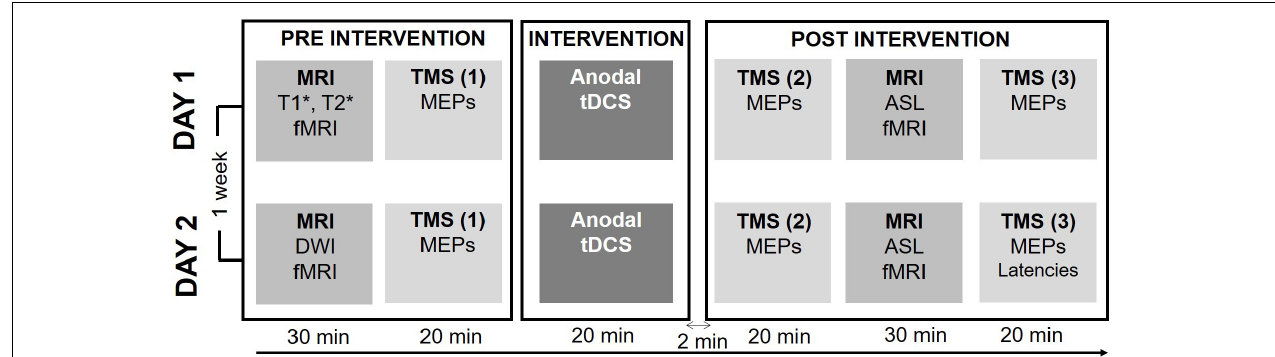
FIGURE 1 | Experimental procedure. Each session started by a baseline measure consisting of a structural and functional MRI (fMRI) exam and baseline physiological measures of corticospinal excitability. Baseline behavioral measures of motor performance during a visuomotor tracking task were recorded during the fMRI sequence. After baseline measures, 20 min of either active or sham TDCS was applied. Directly after the intervention corticospinal excitability was reassessed, followed by the post-intervention run of the fMRI, Arterial Spin Labeling (ALS) and Resting-state fMRI (rs-fMRI) sequences. The post-intervention was concluded by the second measure of corticospinal excitability. In the second session, the individual latency profile was assessed by measuring the MEP latency following stimulation with different coil